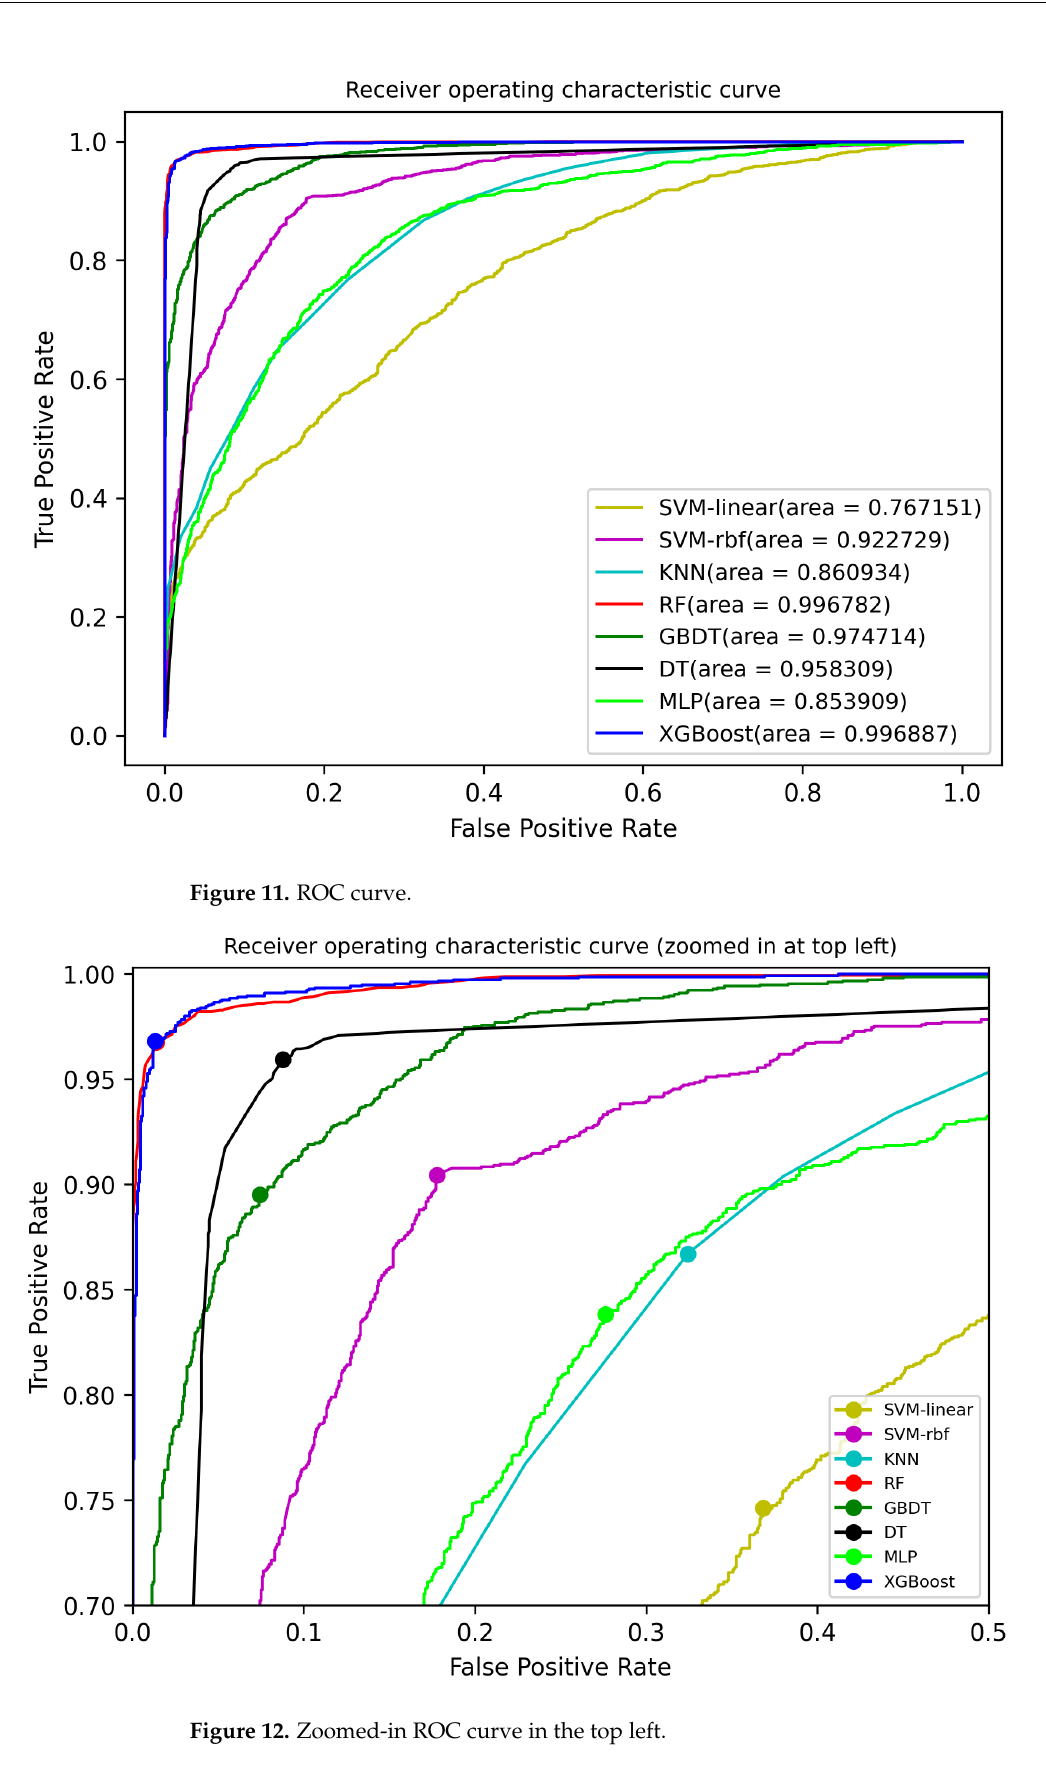
Figure 12. Zoomed-in ROC curve in the top